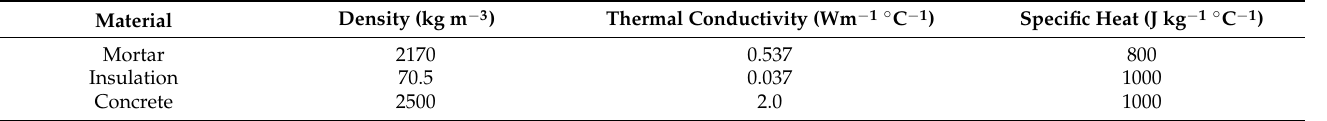
Figure 7. Cross-section of the FE model (dimensions in metres). Table 2. Properties of the materials in the FE model.